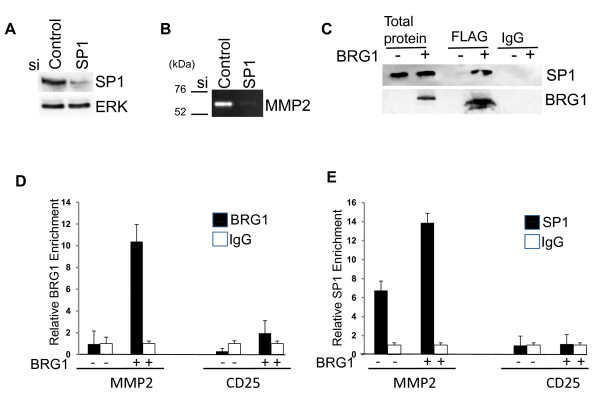
SP1 interacts with BRG1 to regulate MMP2 expression. A. SK-MEL5 +BRG1 cells were transfected with Acell SMART Pool siRNAs targeting SP1 or red non-targeting siRNAs. SP1 expression was analyzed by Western blotting 144 hours after transfection. B. MMP2 secretion in control and SP1 down-regulated cells was analyzed by zymography 144 hours after transfection. C. Co-immunoprecipitations were performed with FLAG antibody or control IgG. Co-immunoprecipitating proteins were analyzed by Western blotting with the indicated antibodies. D. Chromatin immunoprecipitations (ChIPs) were performed with antibodies to SP1, BRG1, or control IgG and analyzed by qPCR with primers specific for the MMP2 promoter or a control CD25 region. The results from two independent experiments were assayed twice. BRG1 was significantly enriched on the MMP2 promoter compared to the control CD25 region (p < 0.01). SP1 binding to the MMP2 promoter was significantly increased in SK+MEL5+BRG1 compared to control cells (p < 0.01).